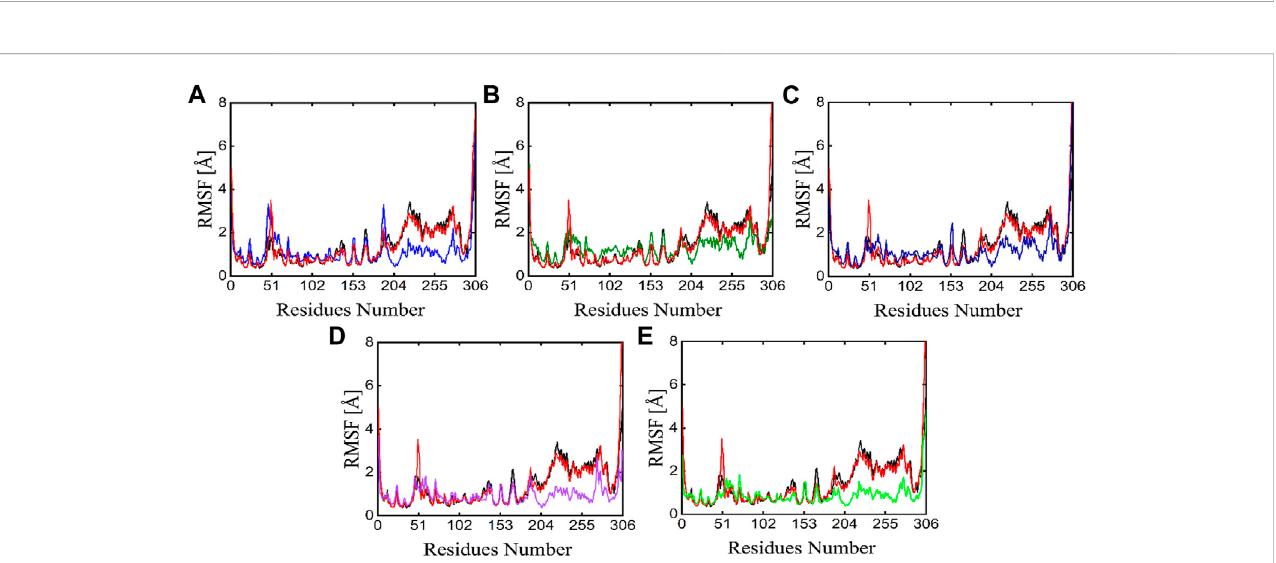
FIGURE 9 RMSF plots of the APO state (Black), control (Red) and the potent phytochemicals (A) Compound 1 (B) Compound 2 (C) Compound 3 (D) Compound 4 and (E) Compound